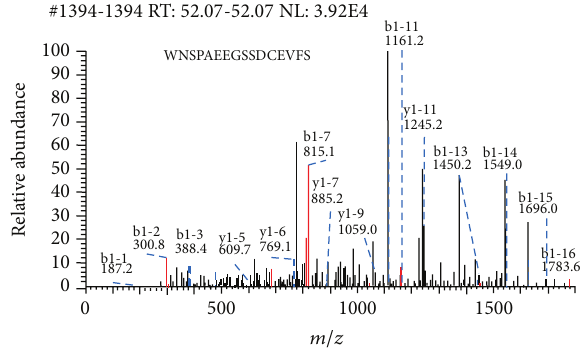
Figure 2: Representative MS/MS spectrum of the peptide of